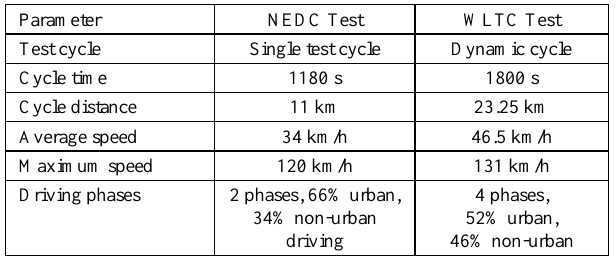
Fig. 3. Schematics of the analyzed REX type drive system Table 3. Comparison of research tests used in simulations